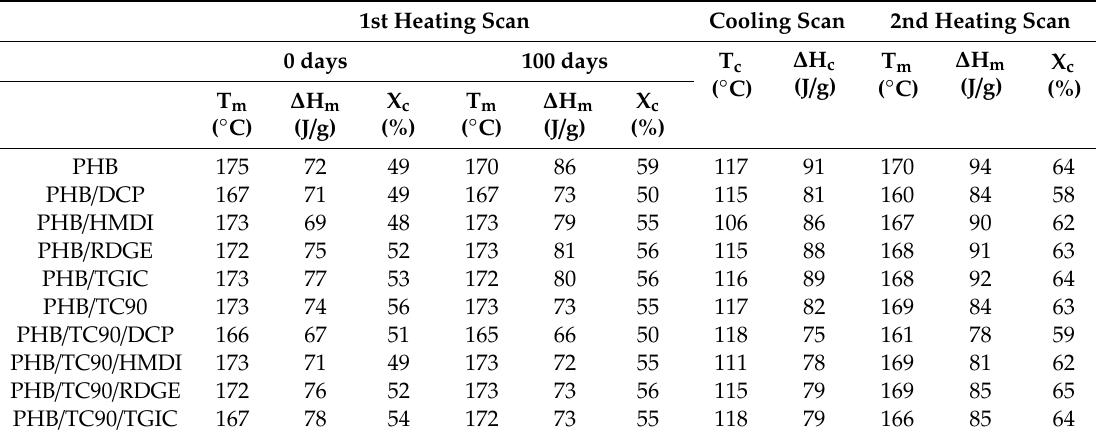
Table 2. Di ff erential scanning calorimetry (DSC) parameters for neat PHB with and without reactive agents and PHB / TC90 composites with and without reactive